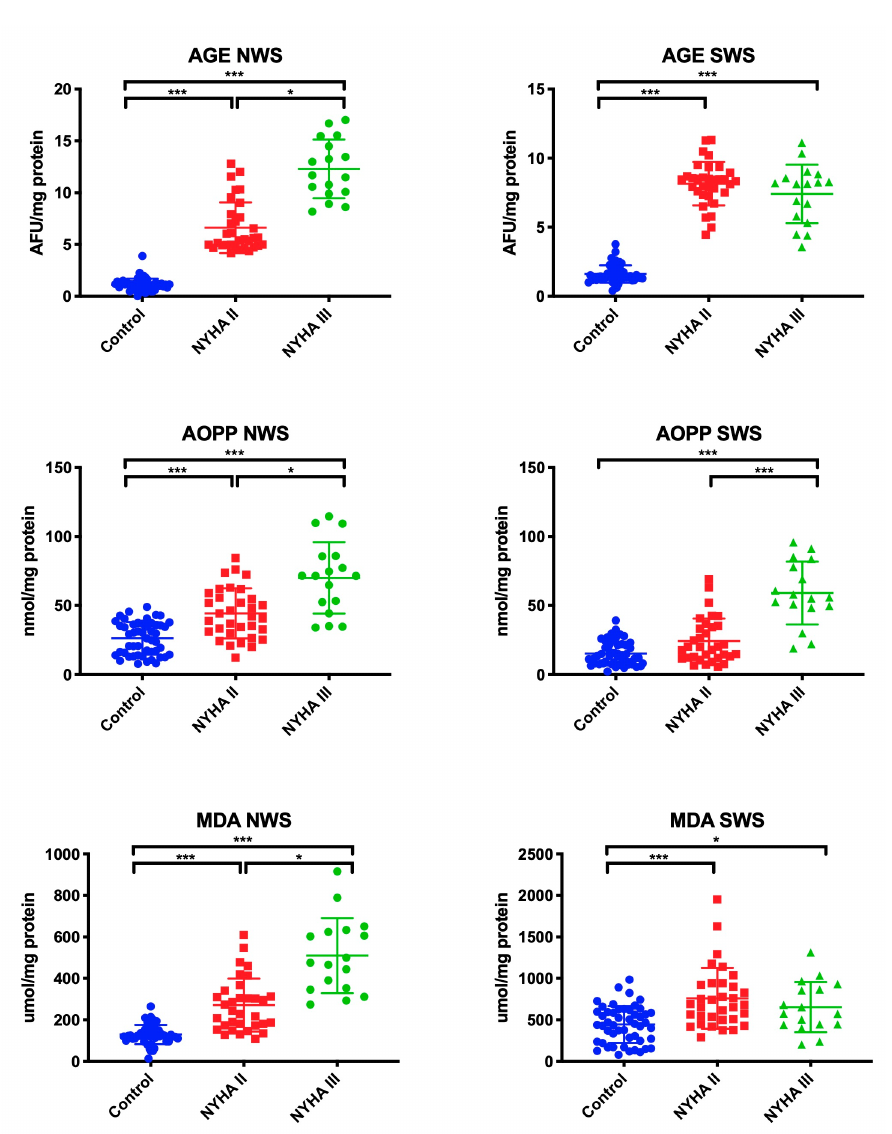
Figure3. Oxidativedamagetoproteinsandlipidsinnon-stimulatedandstimulatedsalivaofHFpatients and the control group. Abbreviations: AGE—advanced glycation end products; AOPP—advanced oxidation protein products; MDA—malondialdehyde; NWS—non-stimulated whole saliva;